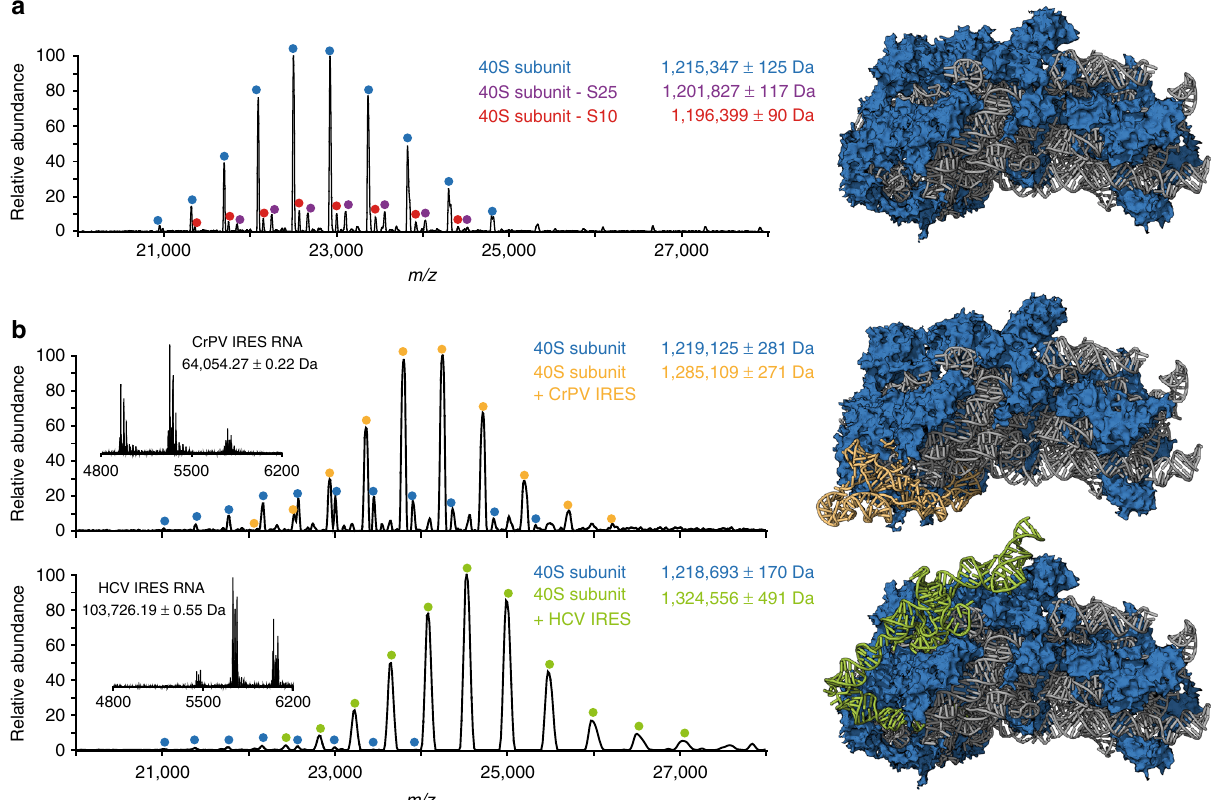
Fig. 6 High-resolution native mass spectra of free and IRES bound human 40S subunits. a Native mass spectrum of human 40S subunit acquired with the recently introduced QE-UHMR mass spectrometer. The well-resolved charge states of three distinct forms of the ribosomal subunit could be detected. The most abundant fully assembled 1.2 MDa 40S particles are labeled in blue, while lower abundant particles lacking either the protein S25 or S10 are labeled in magenta and red, respectively. b Monitoring of the formation of a complex containing human 40S ribosomes and Internal Ribosome Entry Site (IRES) RNA fragments of Cricket Paralysis Virus (CrPV) and Hepatits C virus (HCV). Mass spectra of the RNA fragments alone (insets) provide the accurate mass of the IRES elements. This mass corresponds well with the observed increase in mass of the 40S ribosome upon binding of the RNA indicating that the particles do not undergo a signi fi cant change in composition. Structures of the free 40S ribosomes (PDB 5A2Q) and particles bound by CrPV (PDB 4V91) and HCV IRES (PDB 5A2Q) are shown, with the ribosomal proteins in blue, the rRNA in gray and the IRES elements in yellow and green, respectively 37,